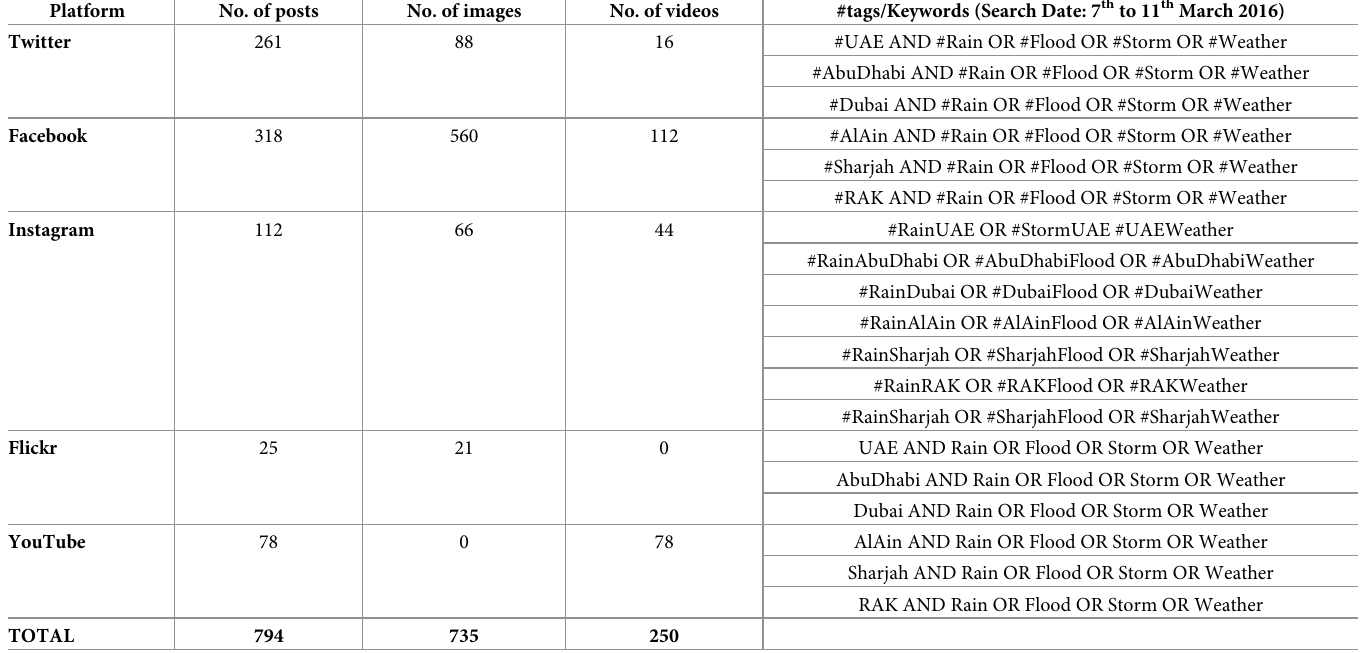
Table 1. Collected data from different social media platforms.